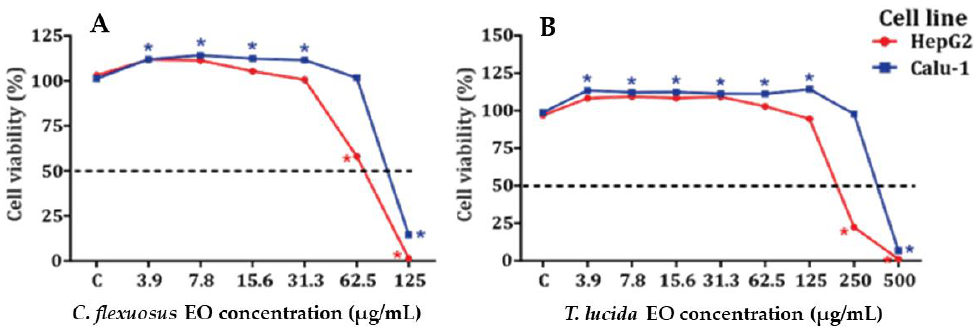
are shown in Figure 1A,B and Tables 3 and S1. C. flexuosus EO was more cytotoxic than T. low concentrations, but this was not concentration dependent.